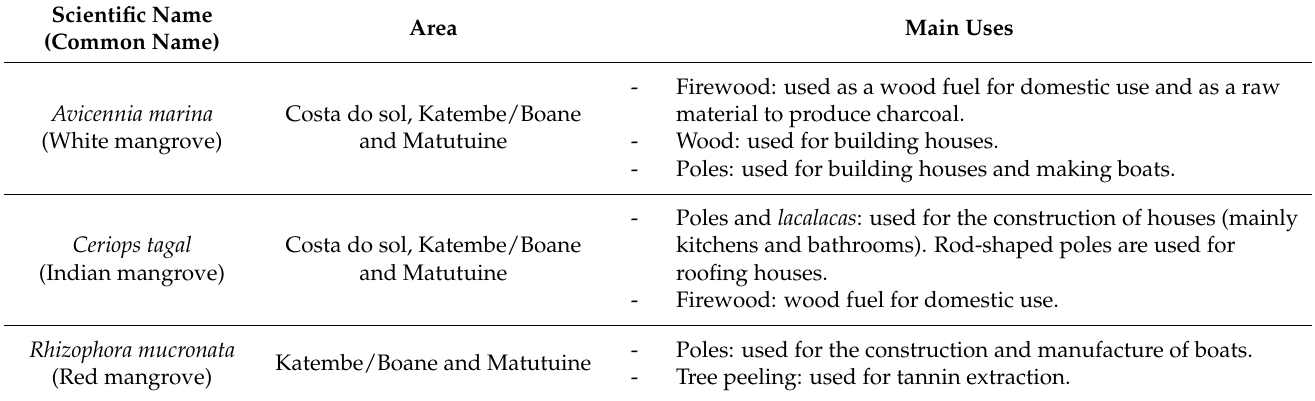
Table 8. Main mangrove species used by the community in Maputo